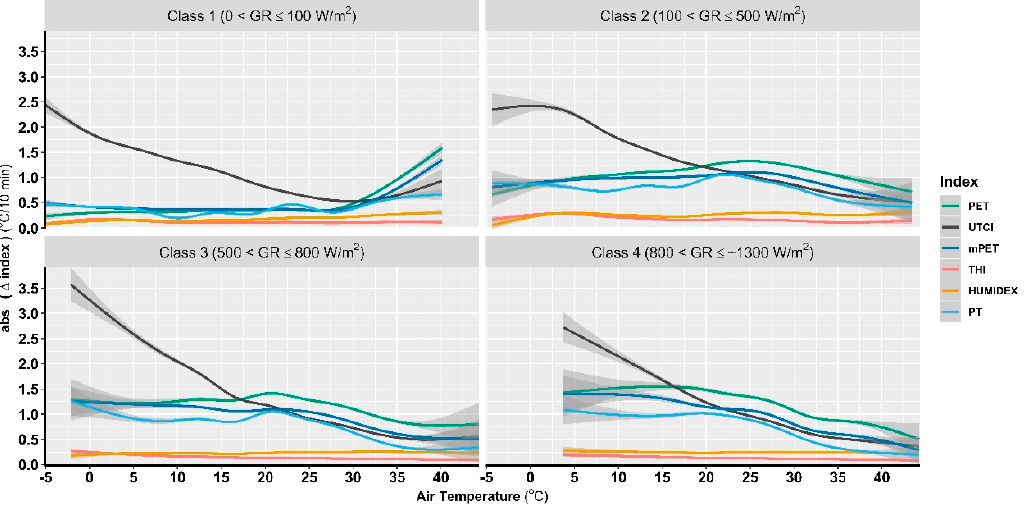
Figure 6. The sensitivity of the indices to air temperature (T a ) variation under different global radiation (GR) conditions.